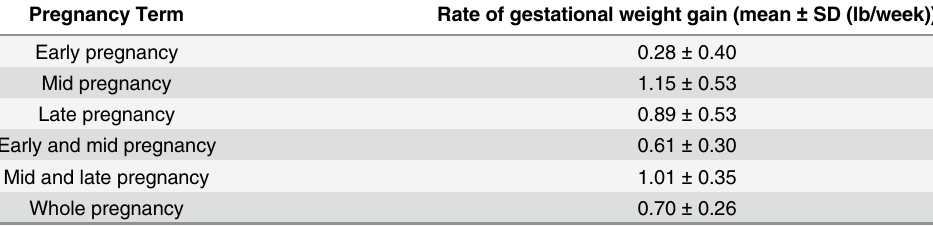
Table 2. Average rate of gestational weight gain.